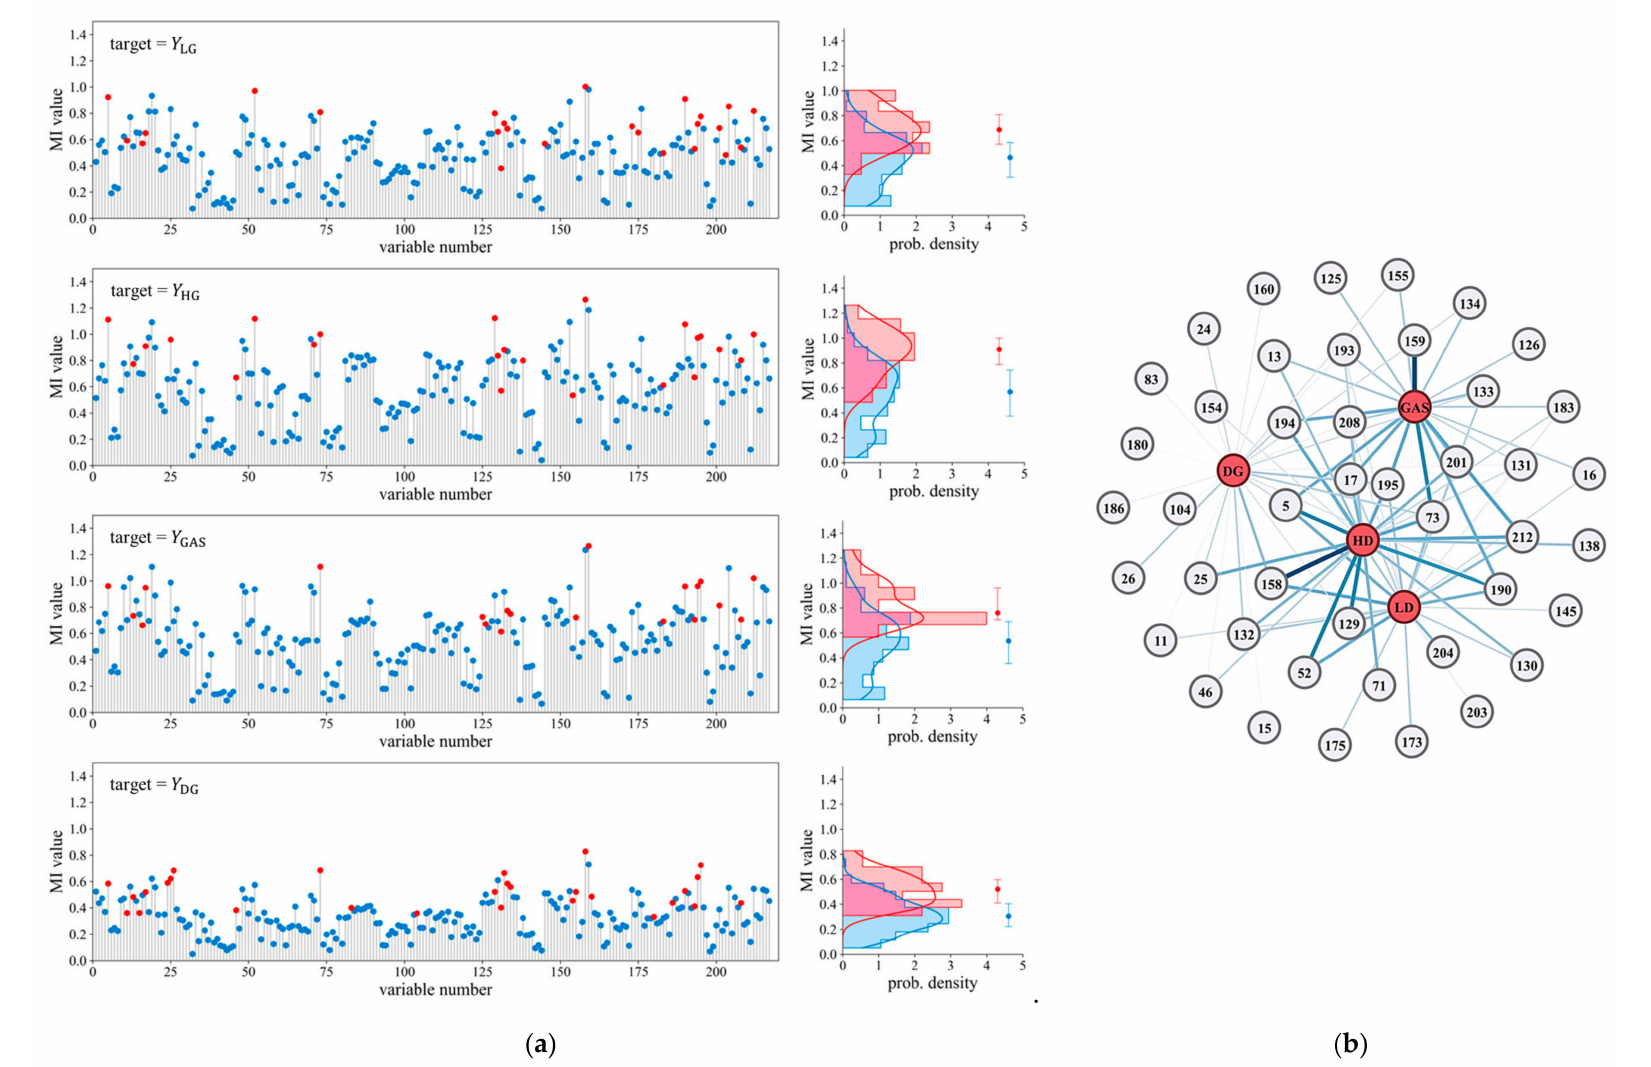
Figure 5. ( a ) Distributions of ˆ I g ( X ; Y ) for MB and non-MB variables identified by CMIM-GIEF; ( b ) compact association network identified by